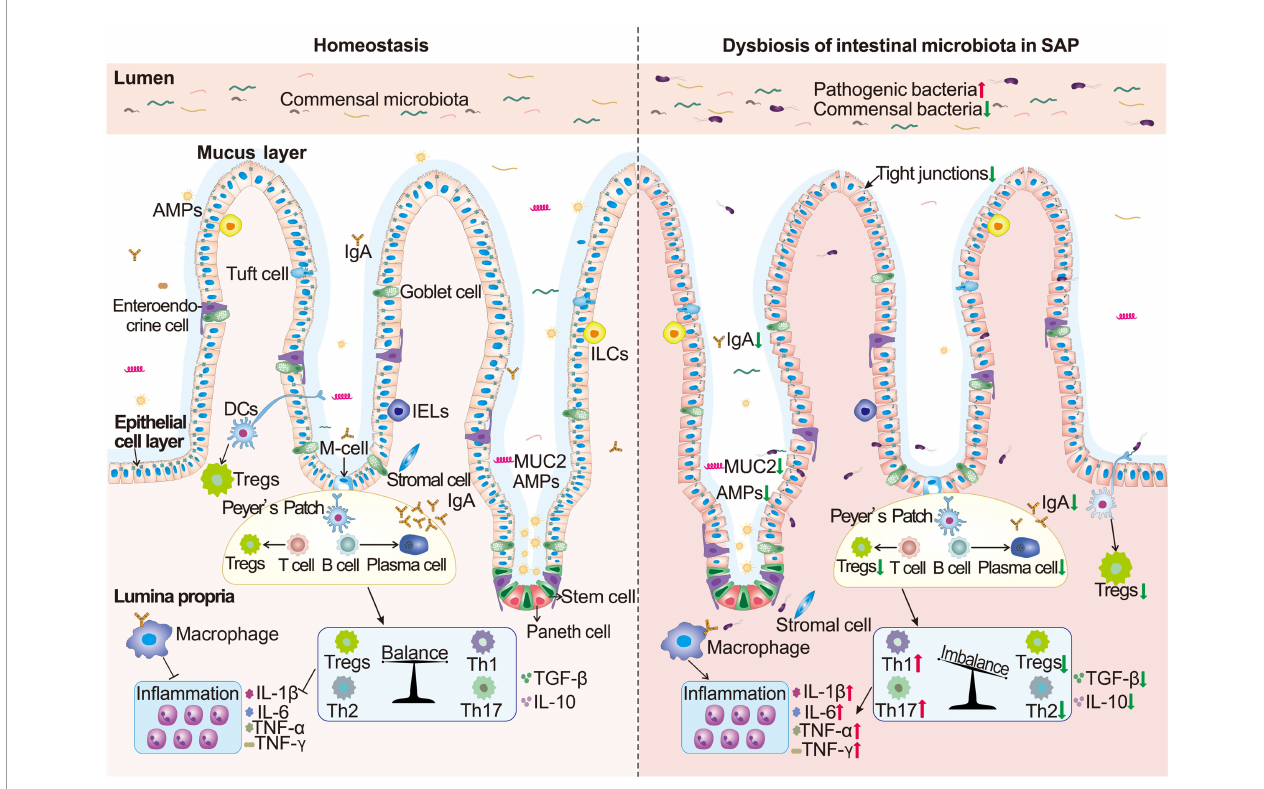
FIGURE 2 | The mechanisms of intestinal barrier disruption mediated by intestinal bacterial dysbiosis. The increase of intestinal pathogenic bacteria and the decrease of commensal metabolites in severe acute pancreatitis (SAP) jointly lead to the thinning of the intestinal mucus layer and the decrease of antimicrobial peptides (AMPs), mucin2 (MUC2), and IgA (SIgA) secretion, resulting in direct contact of pathogenic bacteria with the intestinal epithelial cells (IECs) and an “ in fl ammatory storm ” . The abnormal immune responses further lead to IEC damage, slow renewal, and disruption of the tight junctions (TJs) in epithelial cells, further stimulating excessive pro- in fl ammatory factors on the intestinal mucosal immune system. Finally, the integrity of the intestinal barrier is destroyed, bacteria and products translocate to the lungs, and then PALI